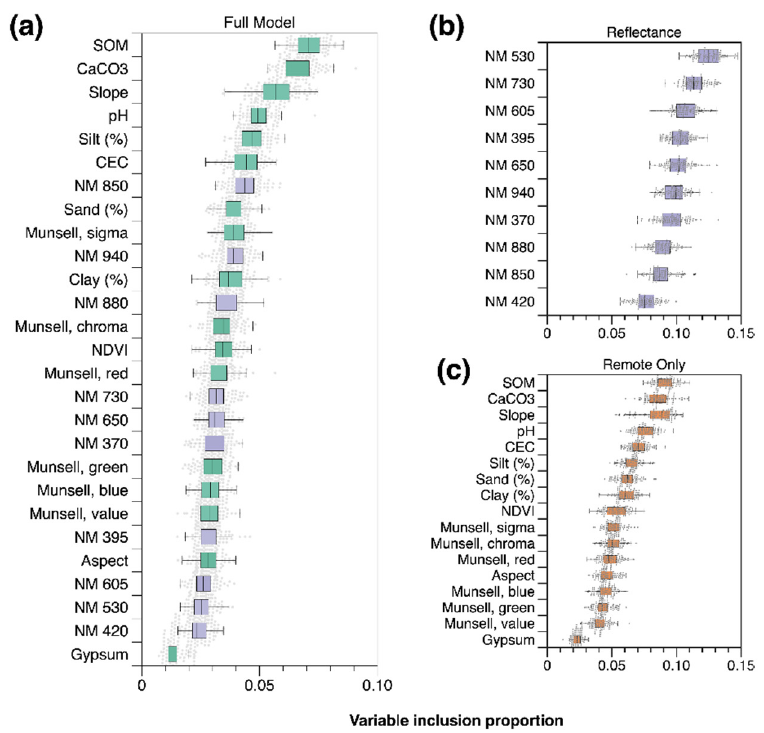
Figure 7. Variable inclusion proportion (VIP) of variables used in the ( a ) full model, ( b ) spec-only model, and ( c ) remote/digital soil map variables model. Bars in each boxplot represent the median VIP of 100 train/test splits for the corresponding model by depth combination; outer edges of the boxes represent the 25 and 75% percentiles; whiskers represent 1.5× the interquartile range; and points represent outlying MAE values greater than 1.5× the interquartile range from soils ( n = 1738) collected from nineteen participating ranches encompassing approximately 17,347 ha in the Southern Great Plains ecoregion of the United States.